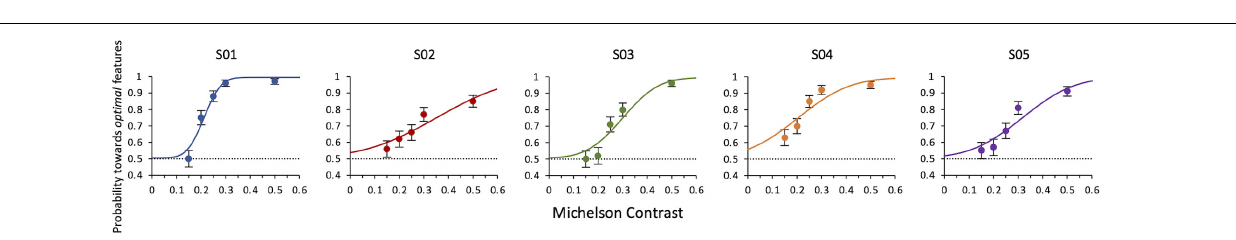
FIGURE 6 | Experiment 3: Probability of selecting the target as a function of contrast of both target and distractor. Data from individual observers. The line is the ML best fit. Individual thresholds are given by contrast values corresponding to 75% level performance and are, respectively, 0.21 ± 0.007, 0.35 ± 0.88, 0.30 ± 0.02, 0.20 ± 0.02, 0.32 ± 0.02. The dashed line indicates the guessing level for this task (0.5 probability).